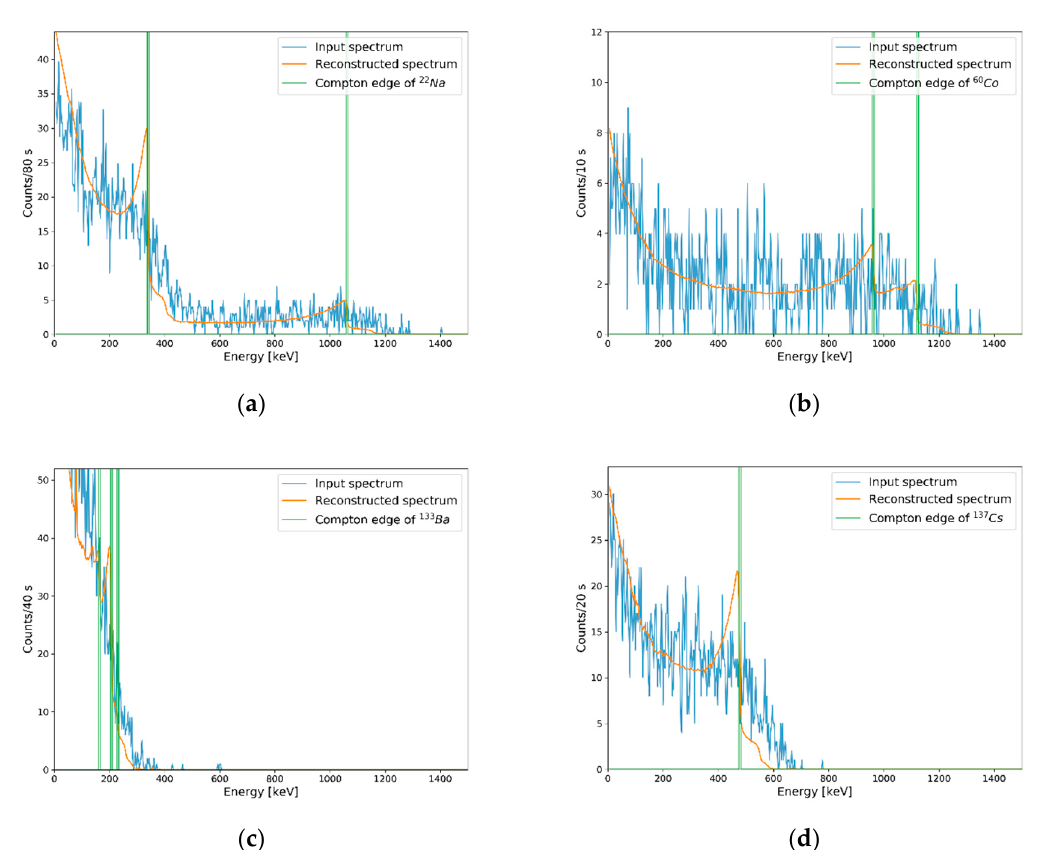
Figure 11. Results of Compton edge reconstruction for experimental spectra with different measuring periods corresponding to each MRC. Reconstruction results on ( a ) measured spectrum for 22 Na during 80 s, ( b ) measured spectrum for 60 Co during 10 s, ( c ) measured spectrum for 133 Ba during 40 s, and ( d ) measured spectrum for 133 Cs during 20 s.